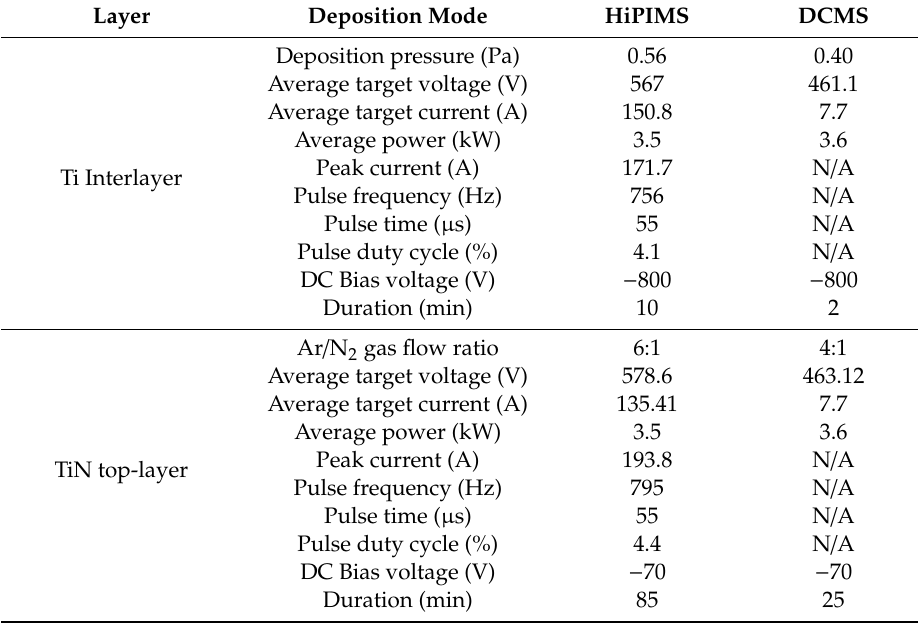
Table 1. HiPIMS and DCMS deposition parameters of TiN